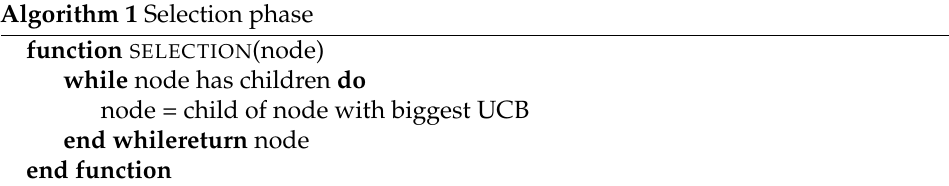
Algorithm 1 Selection phase